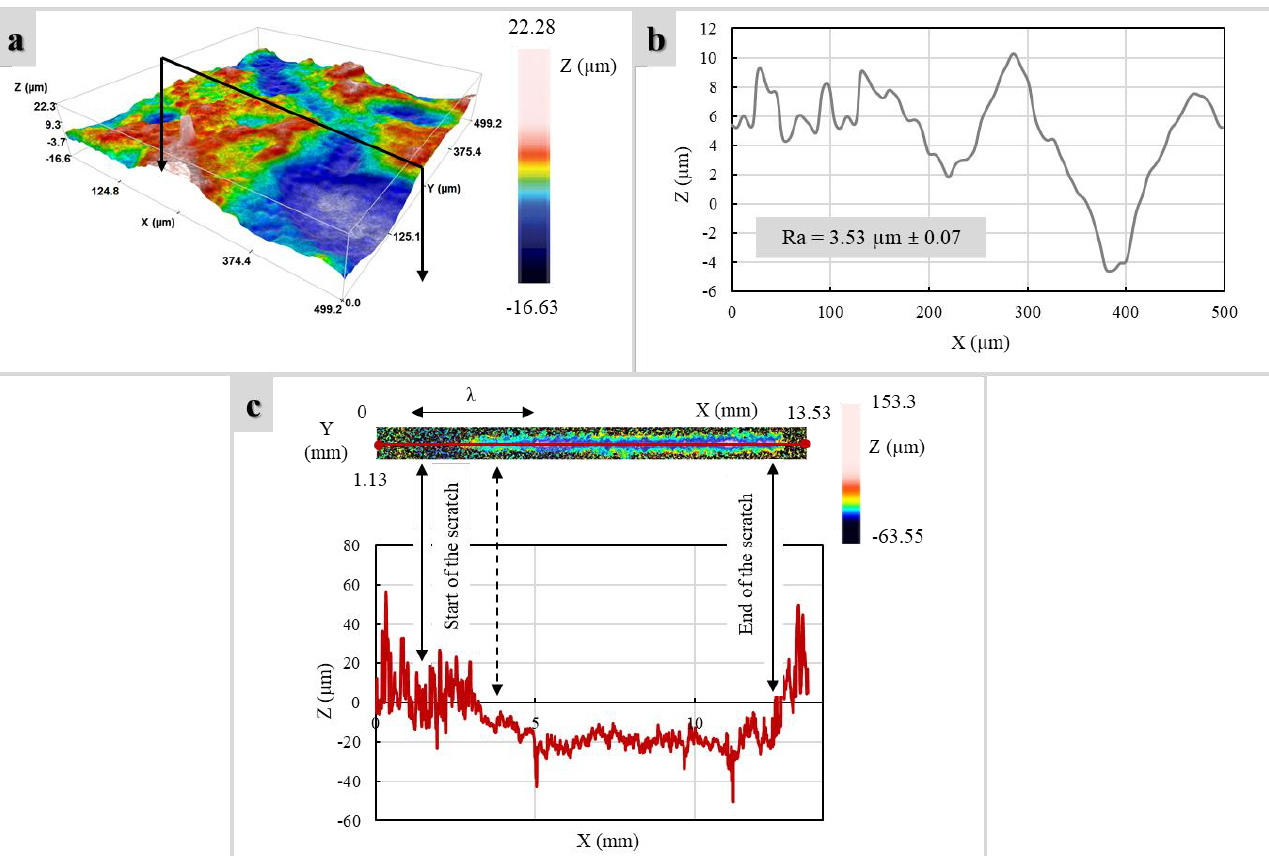
Figure 2. ( a ) 3D topography and ( b ) 2D corresponding profile of surface relative to the received substrate topography; ( c ) 3D topography and corresponding 2D profile of the scratch track of the V1A (1.5 s) sample.